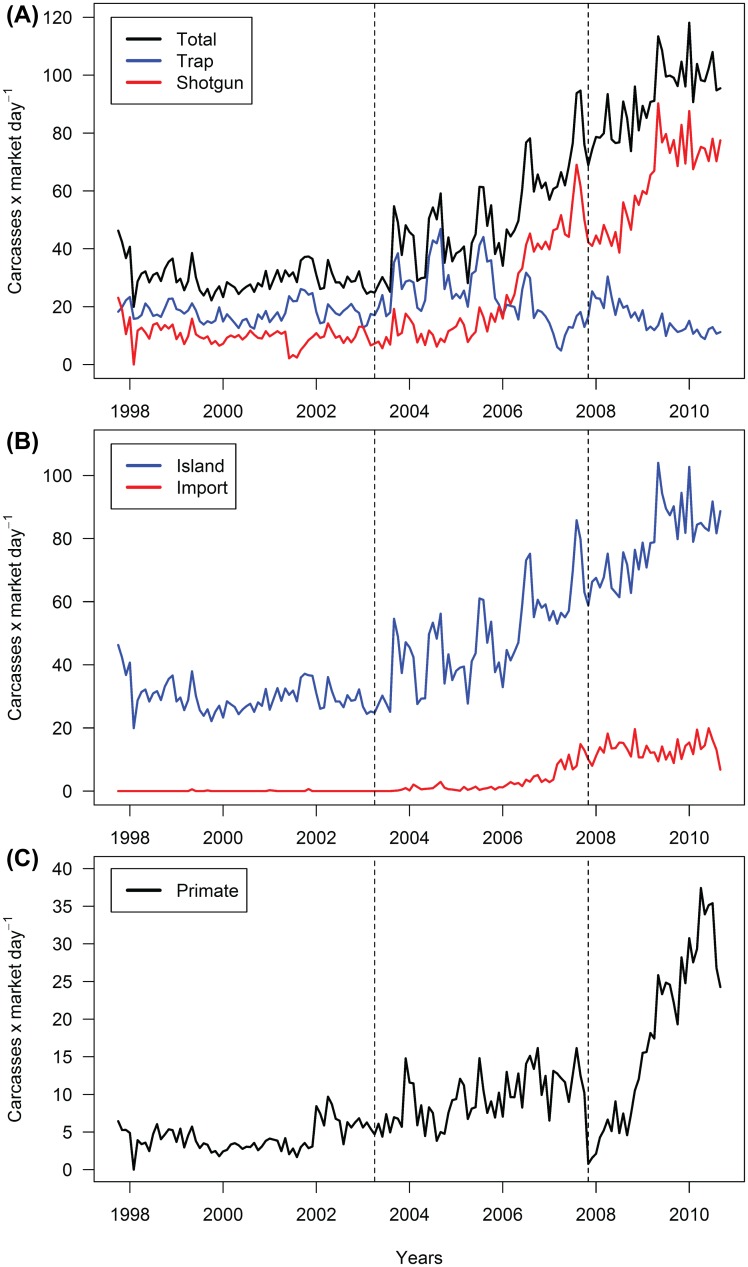
Time series plots of the carcass rates (carcasses/market day).Shown are the (A) total number of carcasses and the number of carcasses captured by shotgun or trap, (B) the number of domestic (island), and (C) the number of primate carcasses. Vertical lines delineate periods. The transition between Pre-ban and Post-ban also coincides with the passing of the October 2007 primate hunting ban.